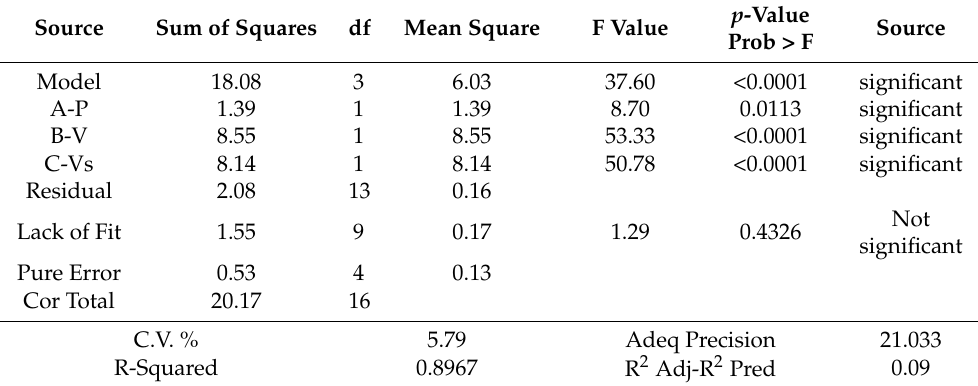
Table 6. Variance analysis of weld penetration fitting model.